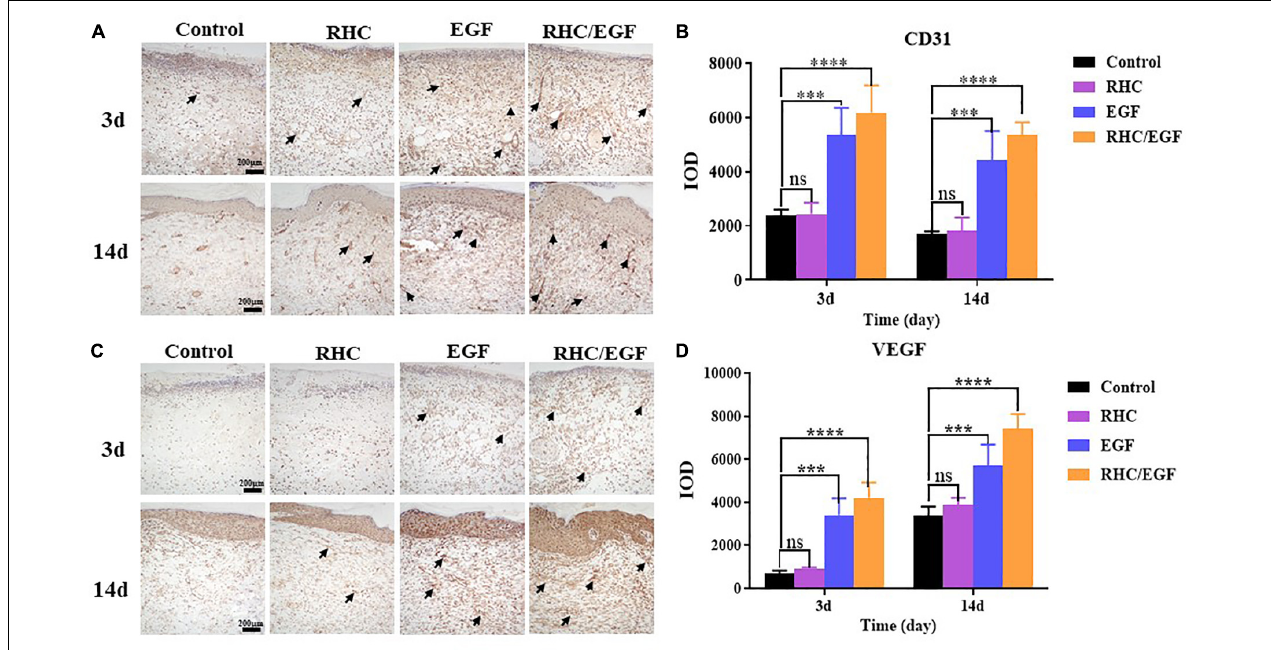
FIGURE 6 | Immunohistochemical examination of CD31 and VEGF expression. (A) Immunohistochemical labeling of CD31-positive cells after treatment for 3 and 14 days. Arrows indicate CD31 expression. (B) Quantitative analysis of CD31-expressing cells at 3 and 14 days measured using ImageJ software. (C) Immunohistochemical labeling of VEGF-positive cells after treatment for 3 and 14 days. Arrows indicate VEGF expression. (D) Quantitative analysis of VEGF-expressing cells measured at 3 and 14 days using ImageJ software. n = 3, means ± SD, *** P < 0.001, **** P < 0.0001 vs. control group, ns means no significant difference vs. control group, P >